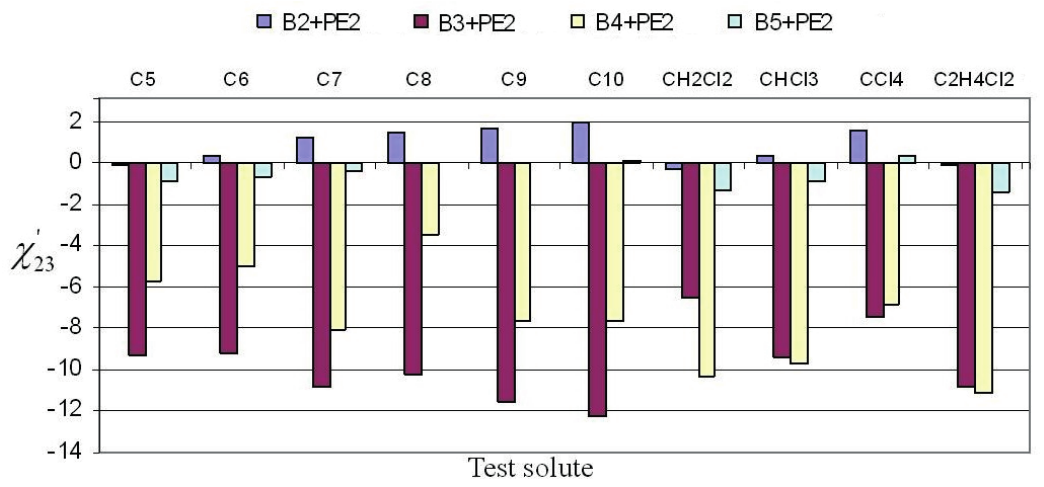
(PE2 – polyethylene; B – fillers: silica modified with: N-2-aminoethyl-3-aminopropyltrimethoxysilane (B2), Figure 1: Filler influence on χ 23 3-aminopropyltriethoxysilane (B3), 3-mercaptopropyl-trimethoxysilane (B4), n-octyltriethoxysilane